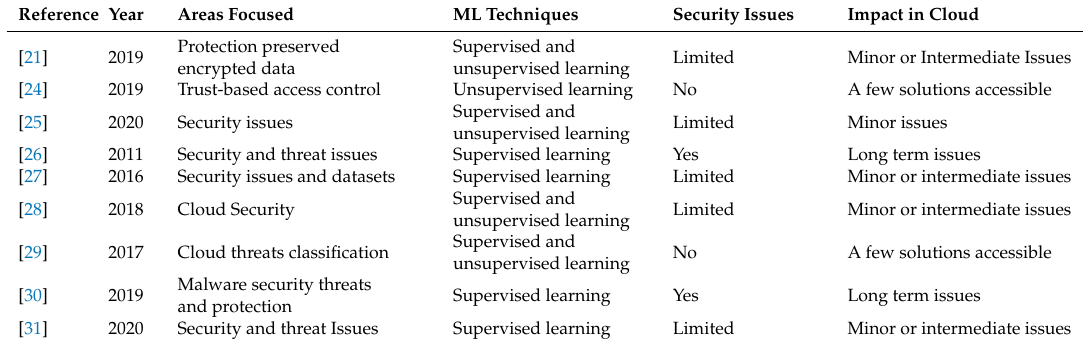
Table 1. Comparison of related